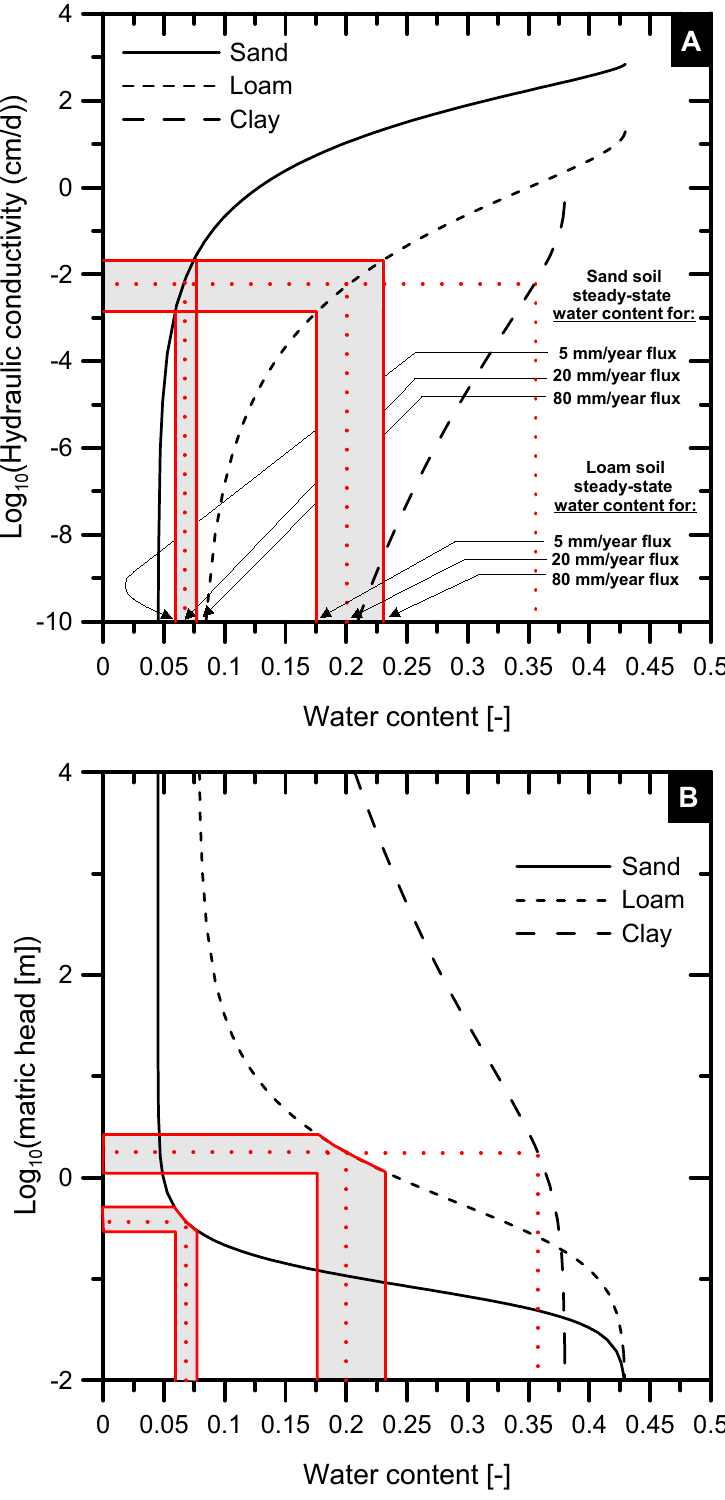
Figure 3. Example of hydraulic conductivity curves (A) and soil water retention curves (B) for the sand, loam, and clay soil textural classes. Source: based on soil hydraulic parameters from [58]. The grey-shaded area in Figure 3 represents the variation in soil water content conditioned by the range in water fluxes (i.e., recharge rates), and thus is a measure of the variation in solute velocity, which has been considered in the solute transport calculations. The imposed variation in water fluxes at the soil surface (i.e., from 5 to 80 mm/year) results in a larger range of steady-state soil water